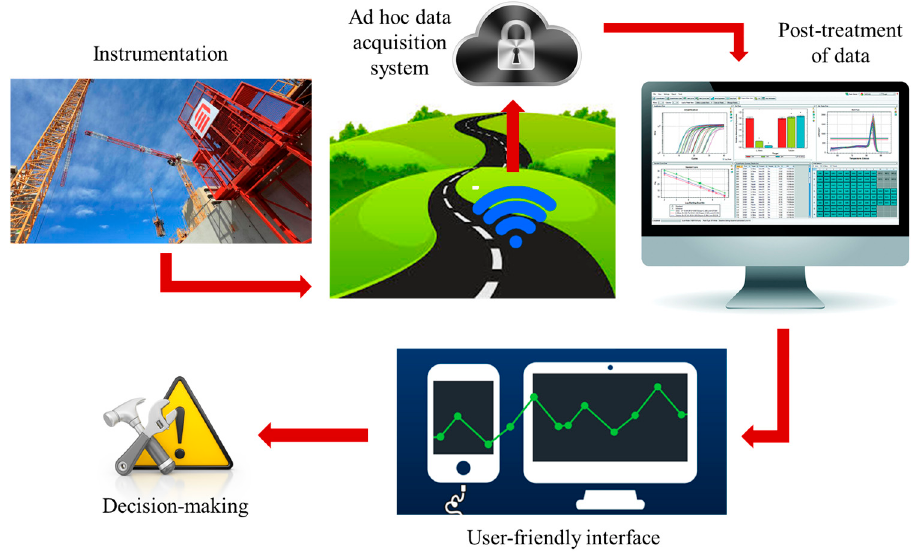
Figure 1. Layout of the monitoring system.